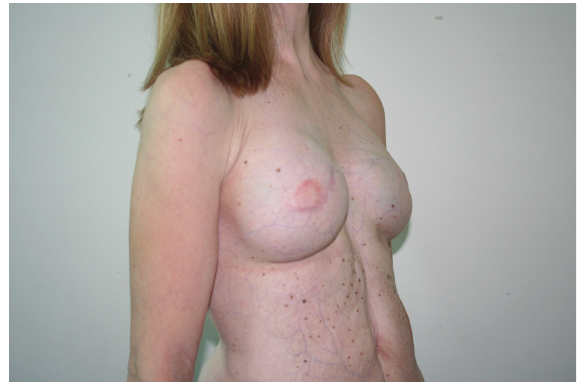
Figure 7: Postoperative oblique